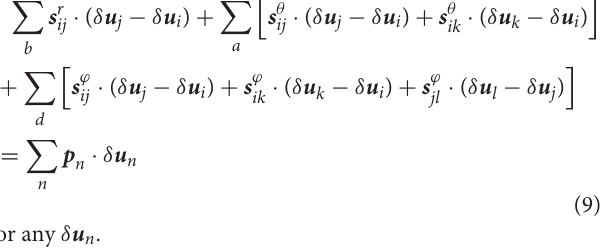
Frontiers in Materials |